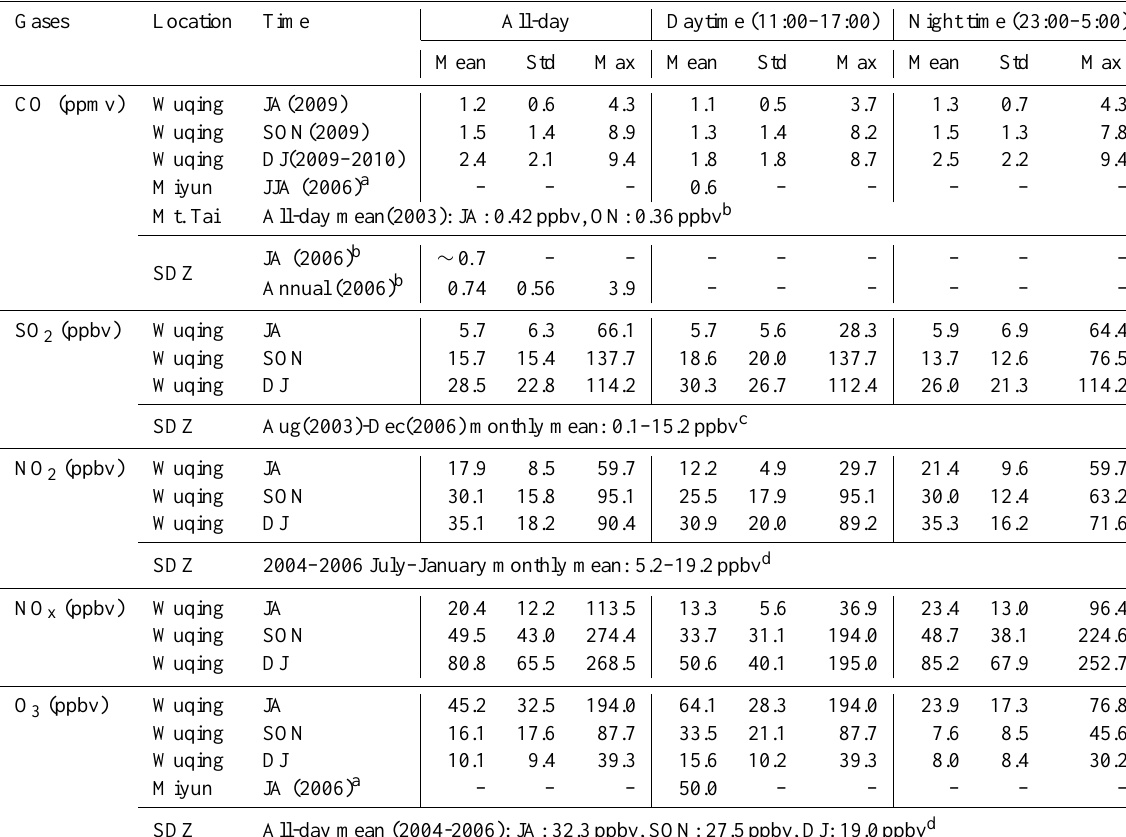
Table 1. Mean trace gas levels for different seasons and different time of day (using hourly averaged data) and comparisons with literature